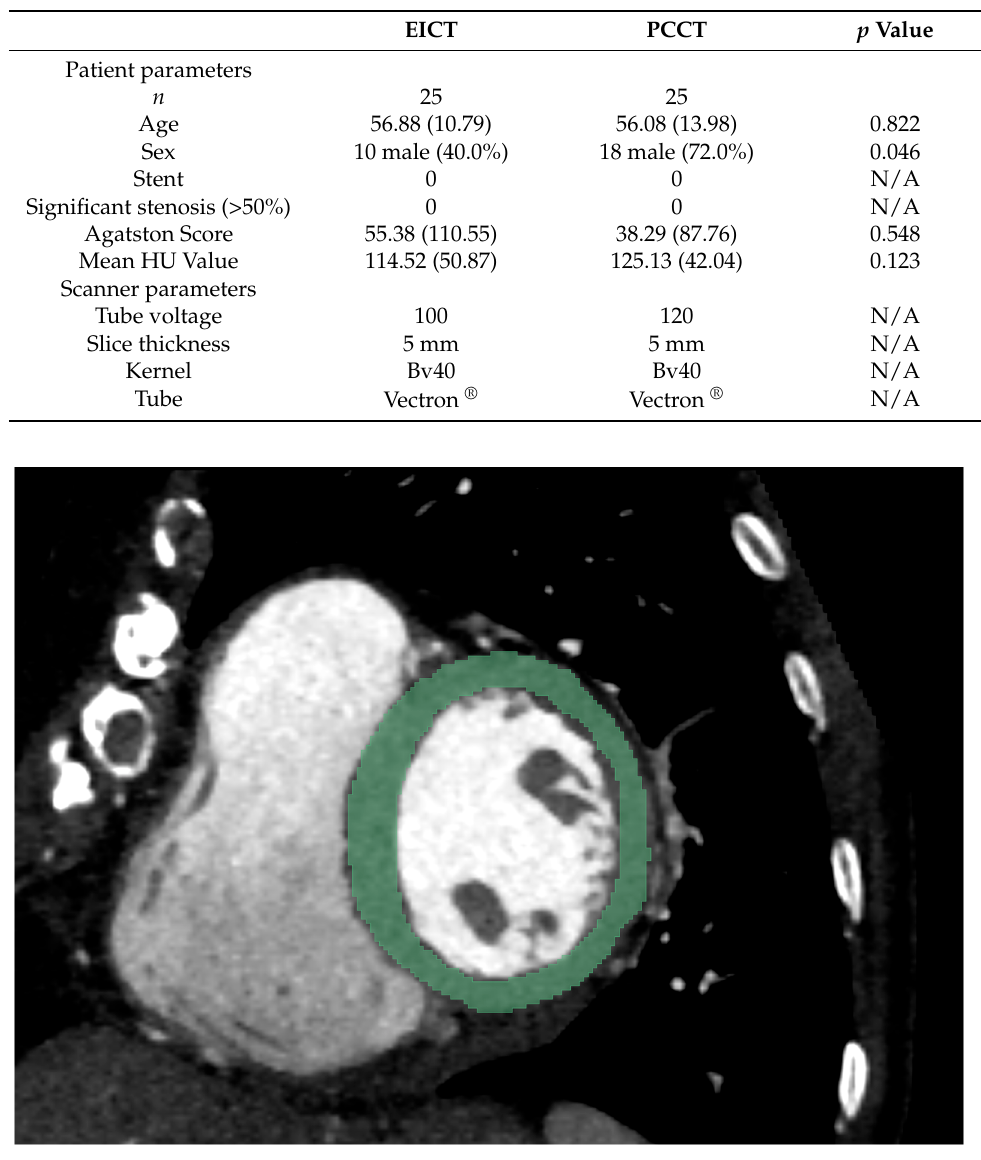
Figure 1. Segmentation of the left-ventricular myocardium was performed on short-axis views, with a slice thickness of 5 mm. An example case of a 79-year female on EICT is shown.